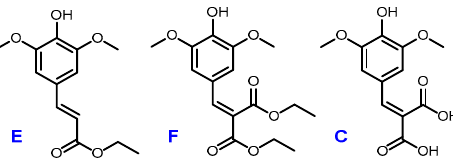
Figure 5. Structures of ethyl sinapate ( E ), diethyl sinapate (DES, F ) and sinapic diacid ( C ).